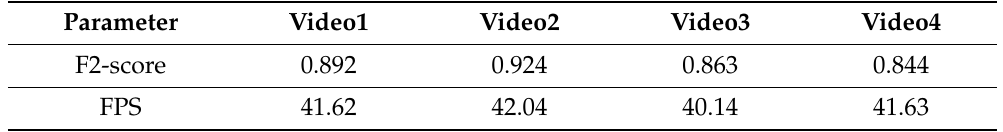
Table 3. The comparisons among different videos in terms of the F2-score and